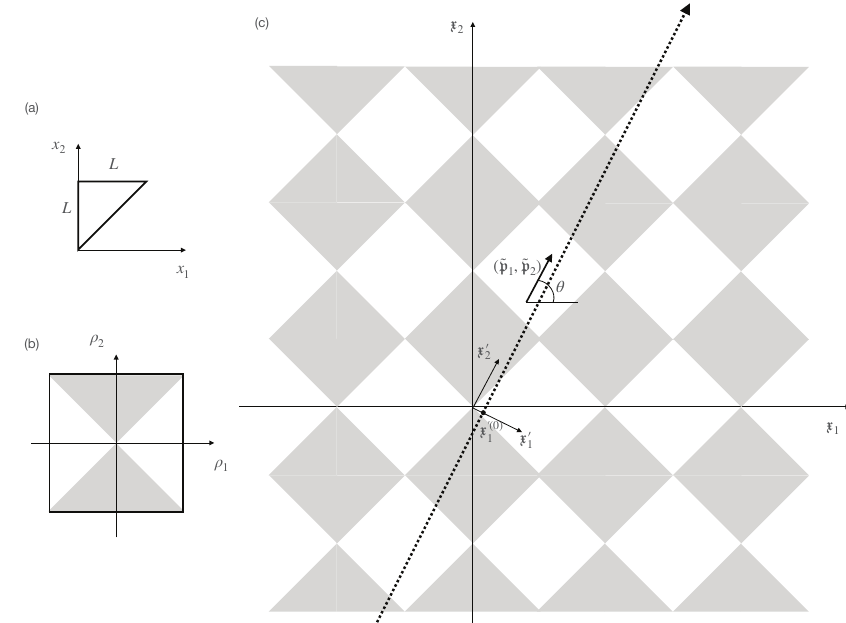
Figure 4: Three coordinate systems used to find and analyze classical nonlinear reso- nances. (a) The original system of coordinates. The size of the box is L . Particle 2 is assumed to be to the right from particle 1. (b) Unfolding the triangle to a square. The original triangle is unfolded, using mirror reflections about the x = x the x hypothenuse, to a square of side 2 L . While the coordinate space is en- 1 2 larged by a factor of 8, momenta are constrained to a 0 < π no reflective walls inside the square; the outer wall, generated by the x remains. Grey areas correspond to positive values of the function sign ( | ρ this function is a part of the perturbation (19). (c) Unfolding the square to a plane. The square of subfigure (b) is unfolded to a plane, via sequential mirror reflections with respect to its walls. Reflective walls disappear completely. The grey areas cor- respond to the positive values of the function sign ( | x this function is a part of the perturbation (20).